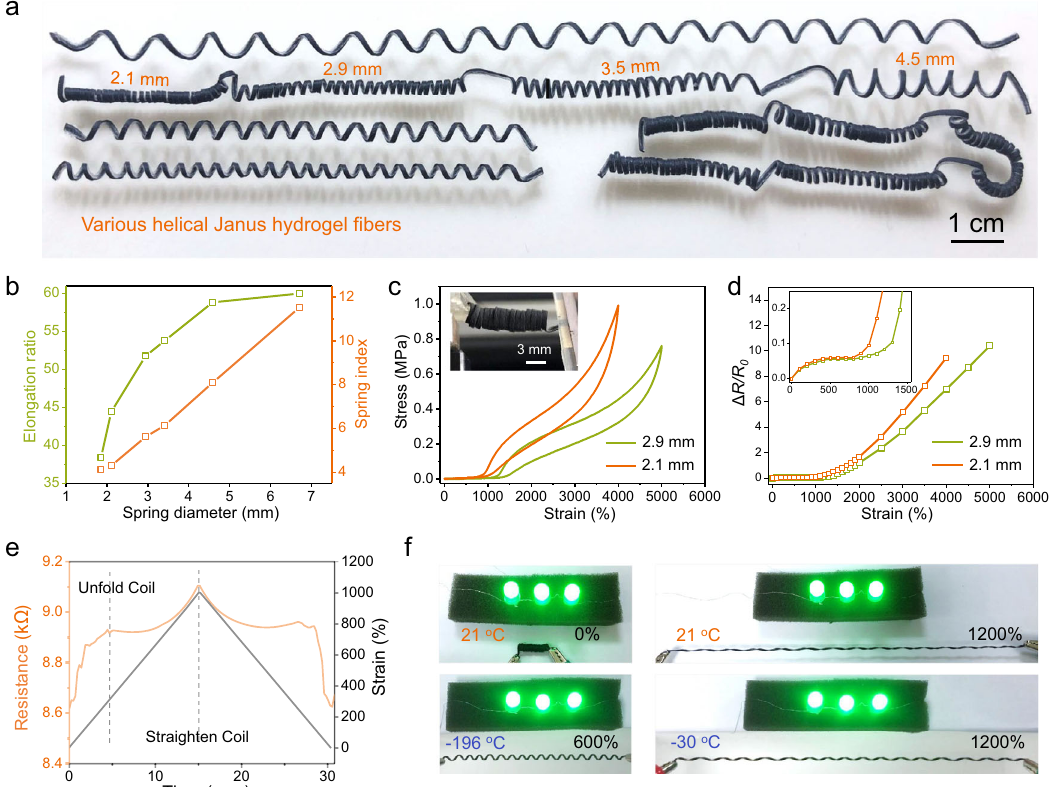
Fig. 5 Helical Janus hydrogel fi ber conductors of extremely large deformations and low temperatures tolerance. a Photograph of various helical Janus fi bers. b Elongation and spring index versus the spring diameter. c Cycled loading of the fi ber conductors to large strains. The inset shows the helical fi ber consisting of intimately contacted coils of ~2.9 mm diameter. d Resistance change of the conductors as a function of tensile strain. e Dynamic resistance of the conductor (~2.9 mm diameter) under a 1000% strain cycle. f Ultrastretchable and low temperatures tolerable LED